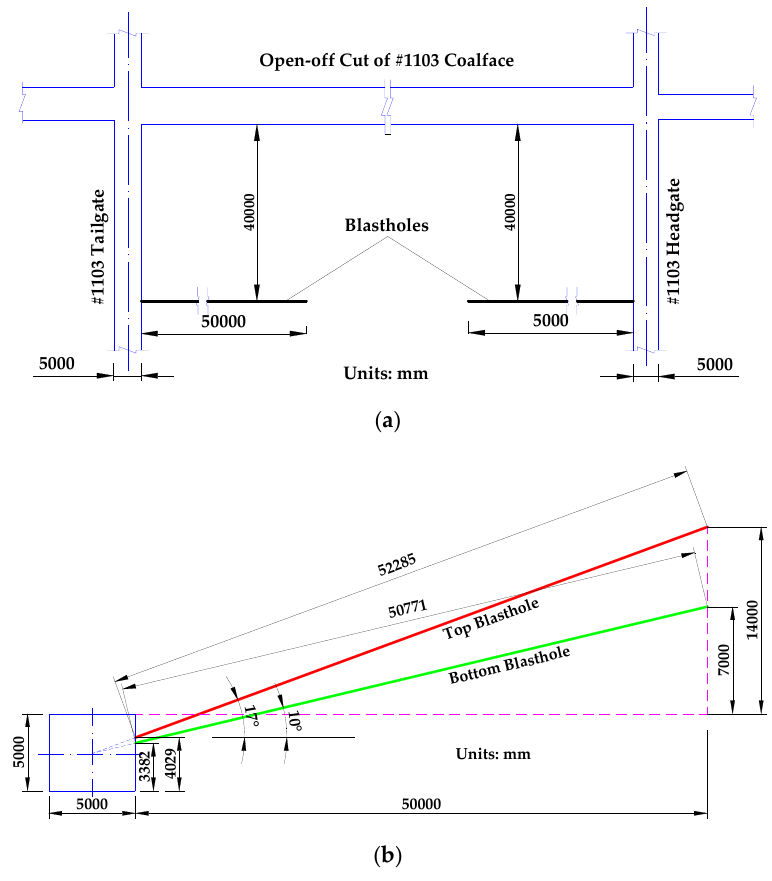
Figure 20. Layout of blastholes in the roof of the headgate and tailgate and relevant parameters: ( a ) layout of blastholes; ( b ) profile of a blasthole.